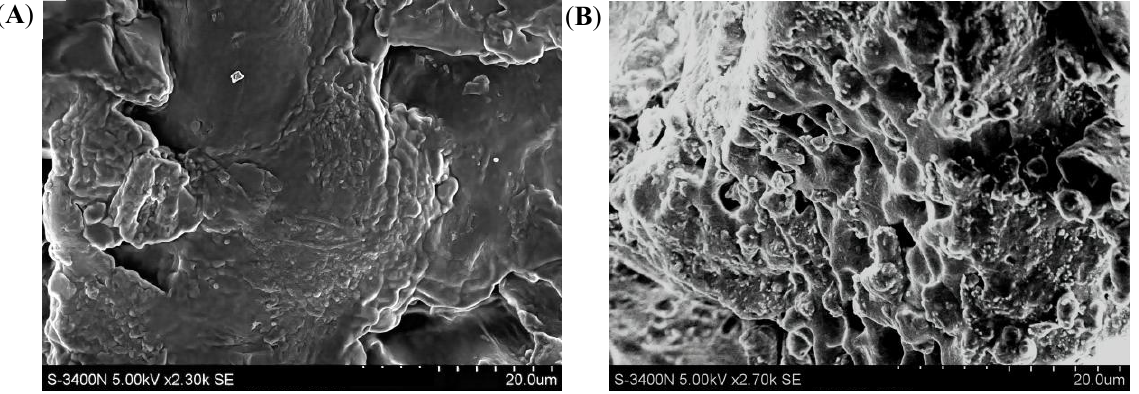
Figure 4. The SEM at 20 μm size of the OM and OP. ( A ): Sample of OM, ( B ): Sample of OP.